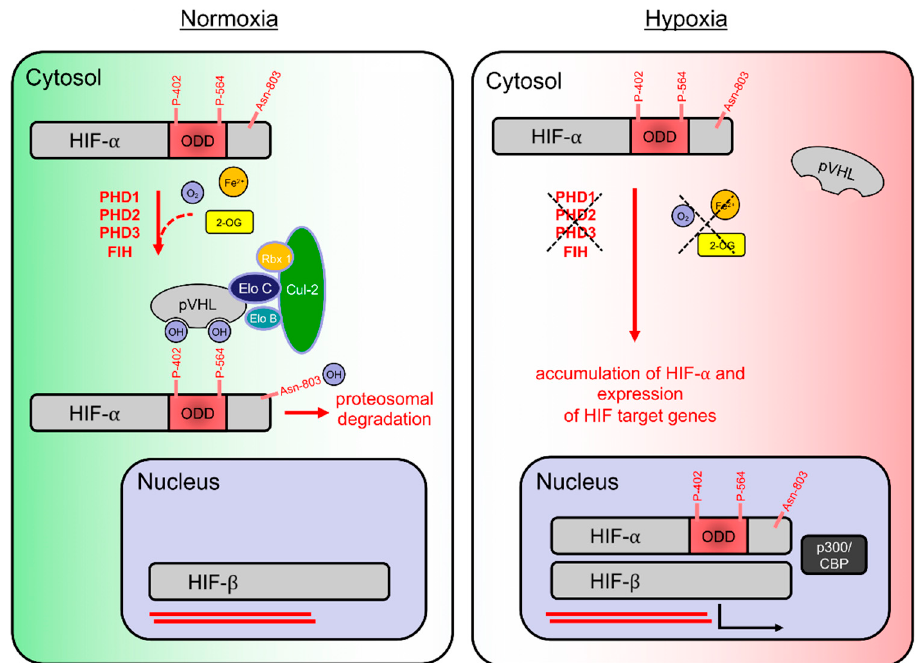
Figure 1. Schematic overview of the hypoxia-inducible pathway under normoxia ( left ) and hypoxia ( right ). Under normoxia, hypoxia-inducible factor (HIF) prolyl hydroxylases (PHD1–3) use oxygen (O 2 ), iron (Fe 2 + ), α -ketoglutarate (also known as 2-oxaloglutarate; (2-OG)) and ascorbic acid (vitamin C; not shown) as co-substrates to hydroxylate the HIF-1 α subunits at two specific proline residues (human: Pro402 and 564) within the oxygen-dependent degradation domain (ODD), thus triggering recognition by the von Hippel-Lindau tumor suppressor protein (pVHL), which, as part of a E3 ubiquitin ligase complex (also containing elongin [Elo] C and B, cullin-2 [Cul-2] and RING-box protein [Rbx] 1), induces proteasomal degradation. HIF-1 α hydroxylation by the factor-inhibiting HIF (FIH) at the asparagine residue (human: Asn803) additionally prevents binding of the transcriptional co-activator histone acetyltransferase p300 / CREB-binding protein (p300 / CBP) (left). In contrast, under hypoxia PHDs and FIH are unable to hydroxylate HIF- α subunits which accumulate and thus migrate to the nucleus, subsequently forming an HIF-complex with HIF- β subunits (right). Formed HIF-complexes bind to the DNA to induce numerous HIF target genes to counteract hypoxia (right).